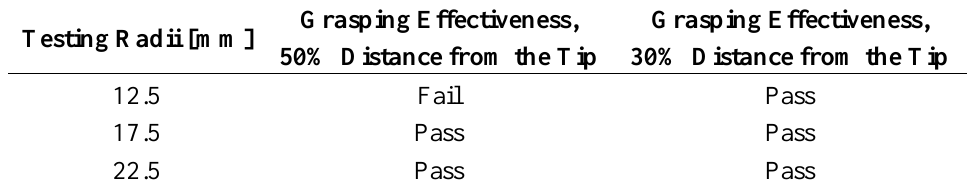
Table 2. Grasping ability in function of object radius and distance from the